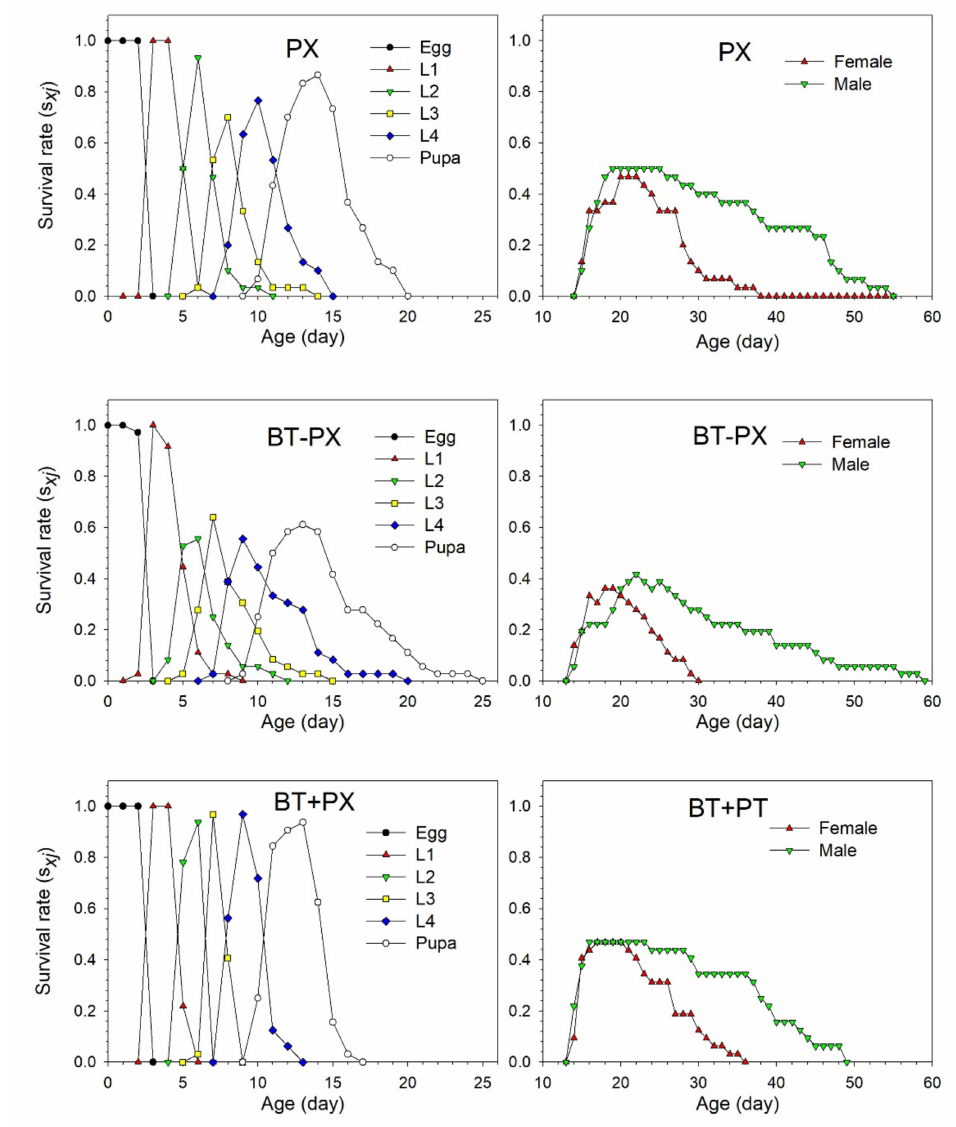
Figure 5. Age-stage specific survival rate ( s xj ) of Plutella xylostella when feeding on Chinese kale alone (PX), with prior Bemisia tabaci damage (BT − PX) or with simultaneous B. tabaci damage (BT + PX). The age-specific survival rate ( l x ), female age-stage specific fecundity ( f x ), age-specific fe- cundity ( m x ), age-specific net maternity value ( l x m x ), and cumulative l x m x value (Cumu. l x m x ) of the DBM in the three different treatments were shown in Figure 6. The l x curve slowly declined from 100% to 90% in the first 24 days in the PX treatment, in the first 15 days in the BT − PX treatment, and in the first 21 days in the BT + PX treatment. Subsequently, the survival rate gradually decreased to zero. The f x curve reached a reproductive peak at 15 and 16 days of age, with the highest fecundity being 43 and 51 hatched eggs in the BT − PX and BT + PX treatments, respectively, which was lower than that in the PX treatment (at 15 days with 56). The m x reached a reproductive peak at 16 days of age, with the highest fecundity being 12 and 24 hatched eggs in the BT − PX and BT + PX treatments, respectively, which was higher than 10 in the PX treatment at 18 days. The Cumu. l x m x values were 45.6 in the BT − PX treatment and 89.7 in the BT + PX treatment, which were 0.67 and 1.32 times those of the PX treatment,